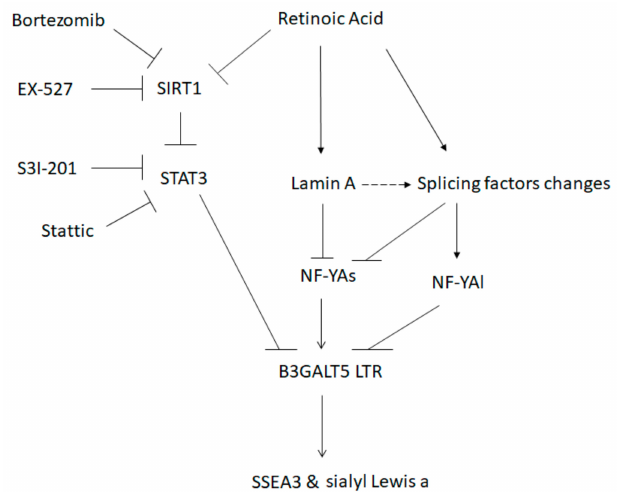
Figure 7. Signaling cascades of RA-mediated repression of B3GALT5 -LTR promoter activity that reduce SSEA3 synthesis in human ES cells. RA induces two pathways that repress B3GALT5 -LTR promoter activity, and thereby downregulates SSEA3 synthesis. One pathway involves RA-mediated SIRT1 repression and results in STAT3 signal enhancement, which causes the activated STAT3 to bind and repress the activity of the B3GALT5 -LTR promoter, thereby reducing SSEA3 synthesis. The second pathway is RA-mediated enhancement of lamin A level, which changes the NFYAs / NFYAl ratio, thereby repressing B3GALT5 -LTR promoter activity and reducing SSEA3 synthesis. Several changes in splicing factor levels (see Discussion) involve a lamin A-dependent or -independent pathway. The drugs used in this study are also shown in this